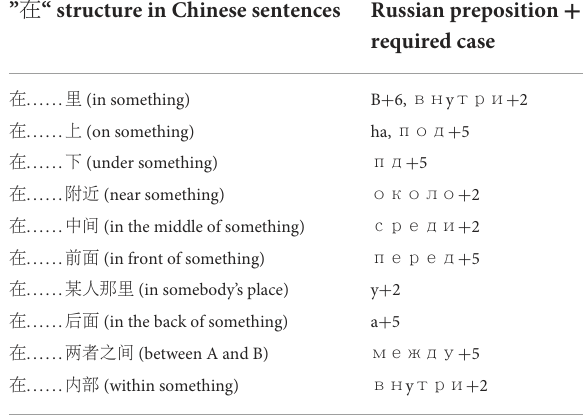
TABLE 1 A comparison of the corresponding relationship between the Chinese preposition “ 在 ” structure to Russian propositions. ” 在 “ structure in Chinese